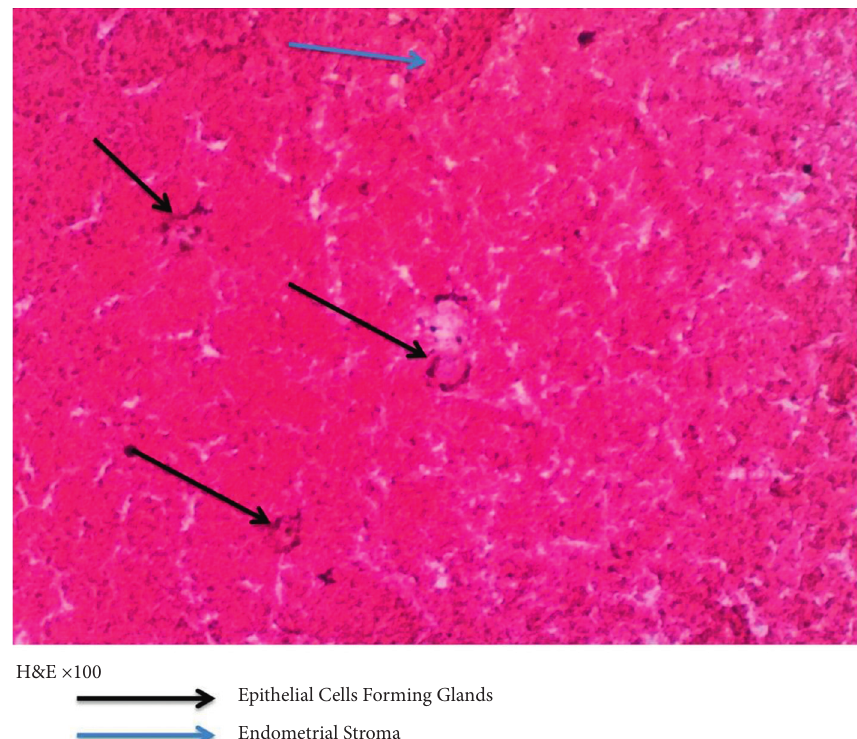
Figure 4: Hematoxylin and eosin staining of pleural fluid sample showing the presence of endometrial stroma and epithelial cells forming